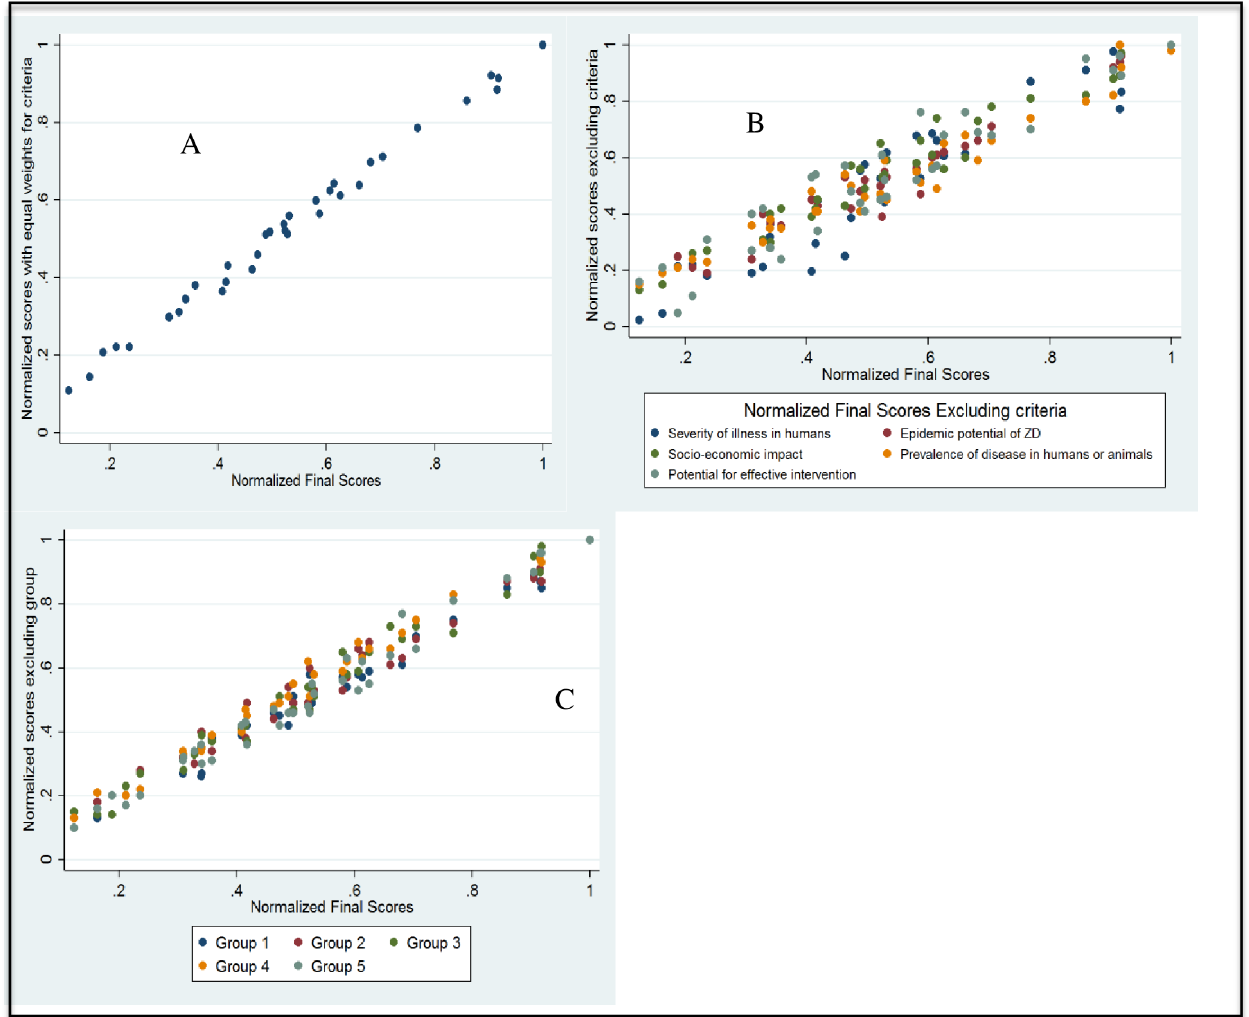
Fig 1. Comparison of normalized scores obtained from the weighted criteria and (a) equal weights; (b) excluding each of the five criteria and (c) excluding each of the five groups.